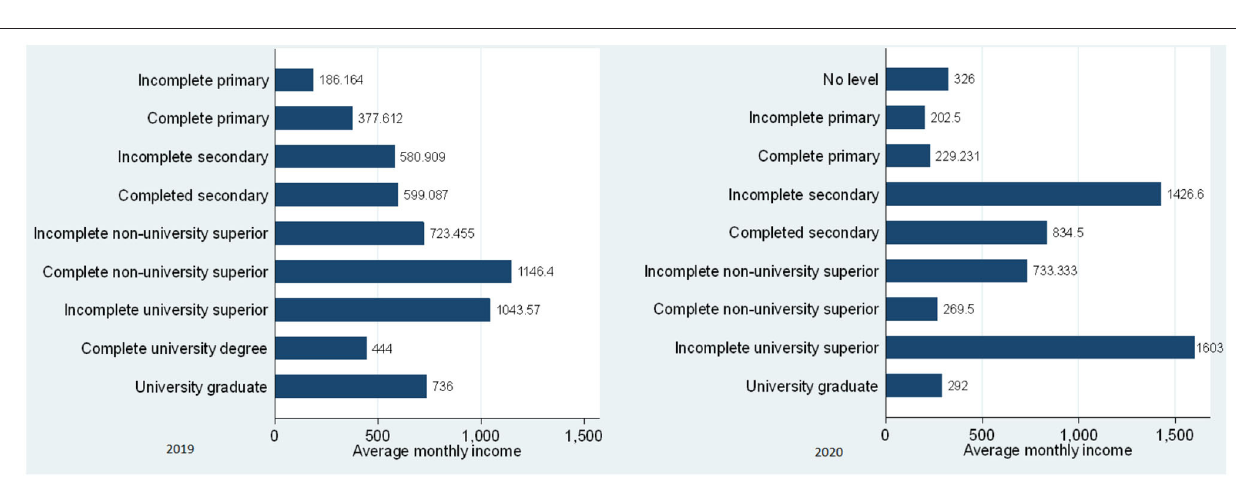
gradually enabled through the development of remote activities ( Figure 3